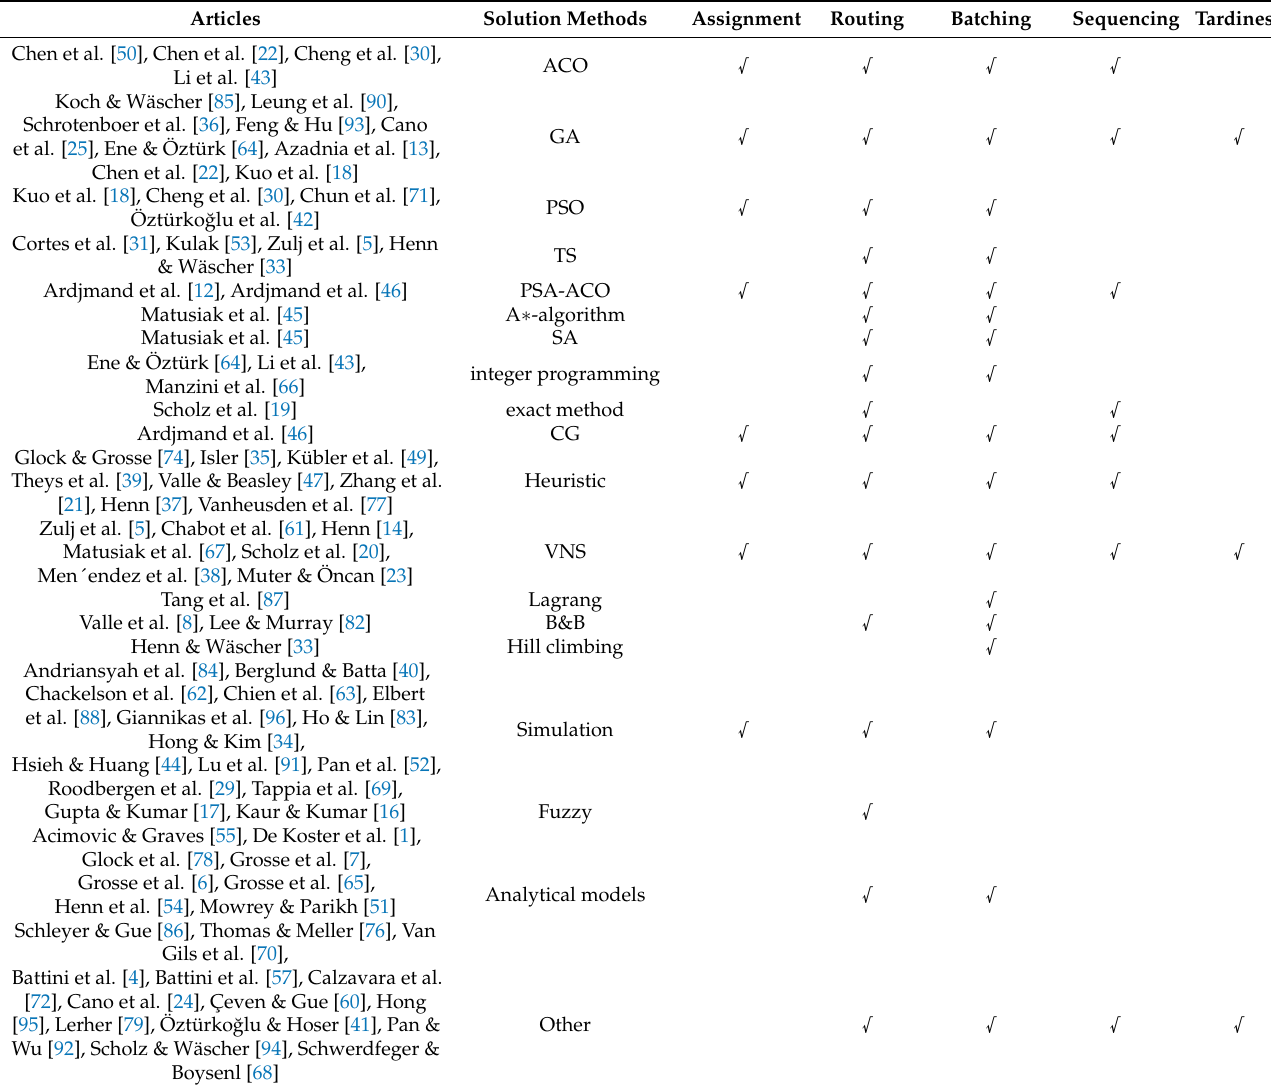
Table 10. Studies using mathematical programming